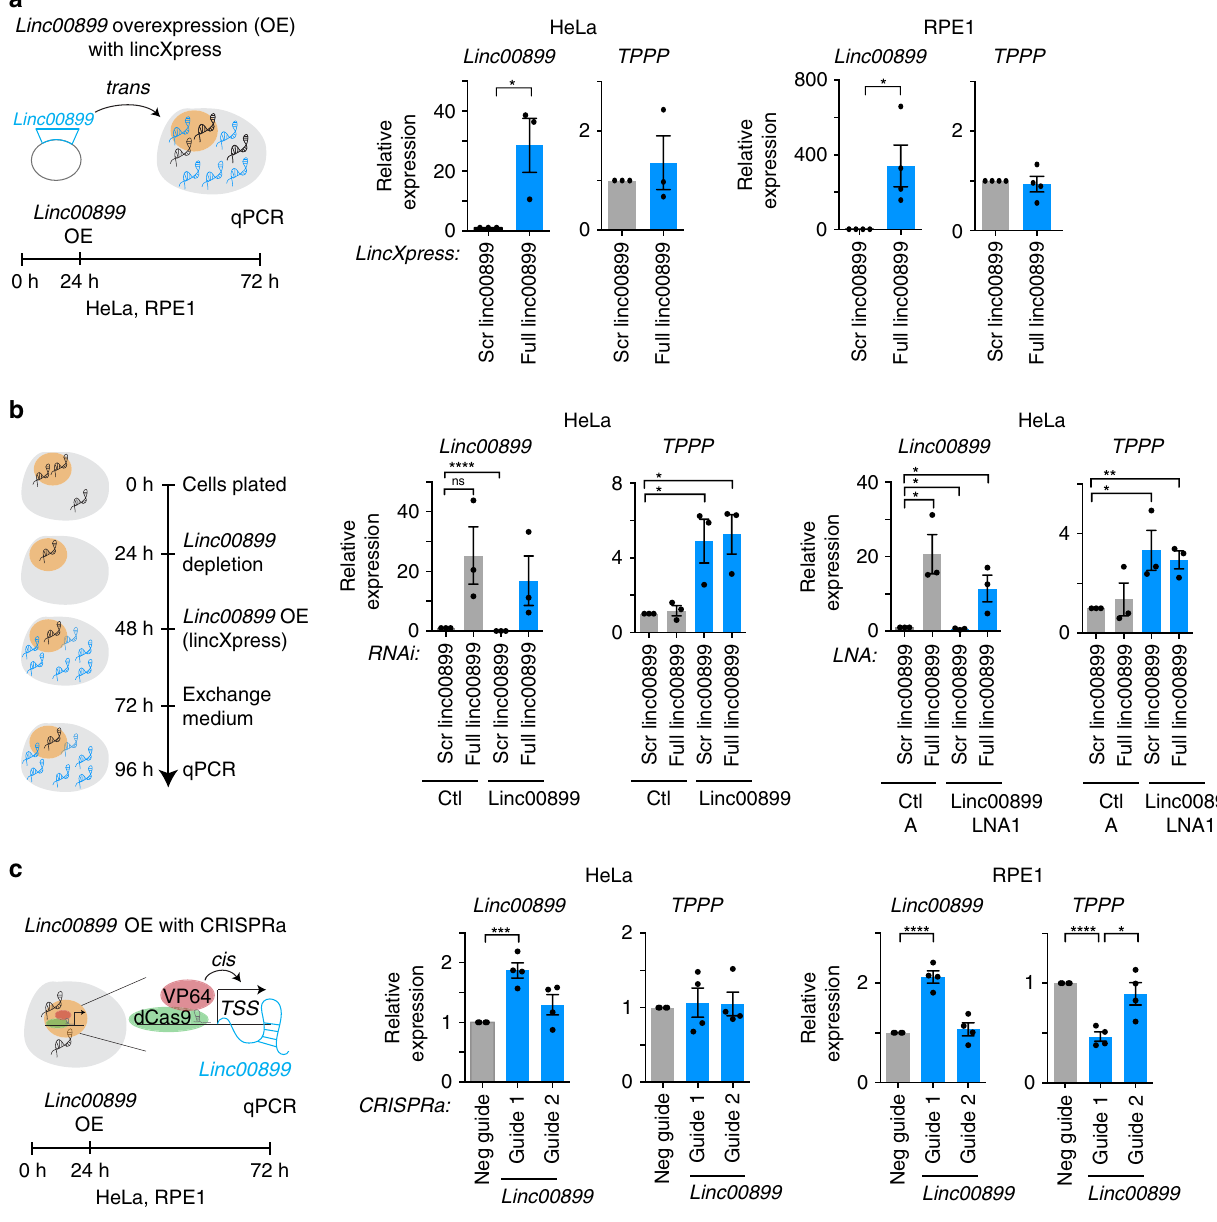
Fig. 8 Gain-of-function and rescue studies of linc00899 and its effect on TPPP expression. a Schematic diagram of ectopic overexpression of linc00899. Linc00899 and TPPP expression were analysed by qPCR after lentiviral overexpression using lincXpress vector encoding linc00899 cDNA in HeLa (left) and RPE1 cells (right). The expression was normalised to the scrambled linc00899 vector (negative control). n = 3 – 4 biological replicates, * P < 0.05 by two- tailed Student ’ s t test. b Rescue of linc00899 function after RNAi- or LNA-mediated depletion of linc00899 in HeLa cells through ectopic overexpression of linc00899 . n = 3 biological replicates, * P < 0.05, ** P < 0.01 and **** P < 0.0001 by two-tailed Student ’ s t test. c Schematic diagram of endogenous overexpression of linc00899 using CRISPRa . Linc00899 and TPPP expression were analysed by qPCR after transduction of dCas9-VP64 and gRNAs targeting different regions of the linc00899 promoter in HeLa (left) and RPE1 cells (right). The expression was normalised to the negative guide (negative control). n = 4 biological replicates, * P < 0.05, *** P < 0.001 and **** P < 0.0001 by two-tailed Student ’ s t test. Data are shown as mean ± S.E.M for a – c . Source data are provided as a Source Data fi